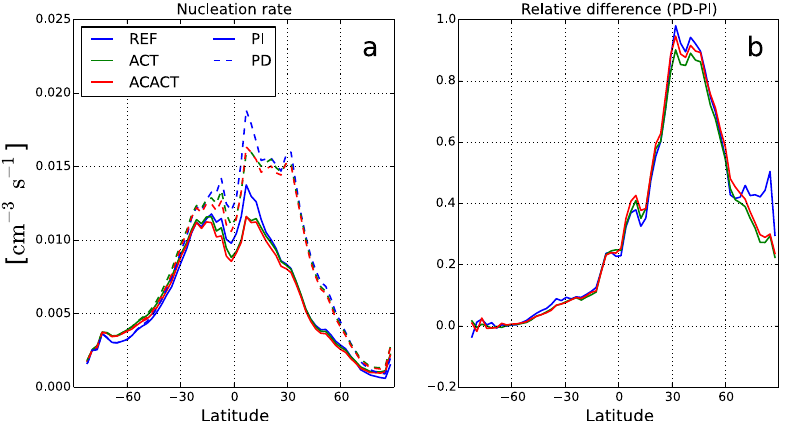
Figure 3. (a) Cloud droplet nucleation rate for PI and PD conditions in cm − 3 s − 1 at 890hPa and (b) the relative anthropogenic change for each model